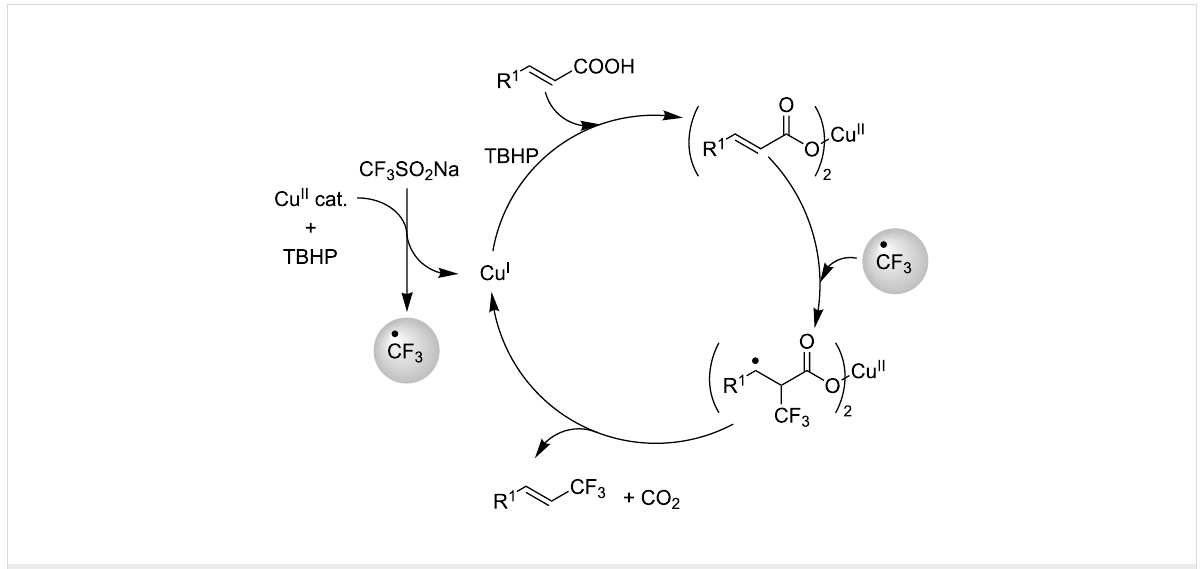
Figure 13: Possible mechanism for the Cu-catalyzed decarboxylative trifluoromethylation of cinnamic acids [62].